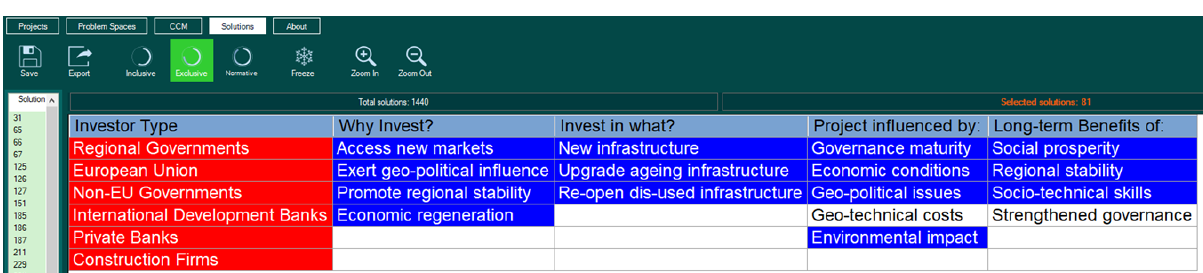
Figure 5: The solution space shows 81 options (out of a possible 1440) in the (strict) exclusive mode, where P is treated as an X